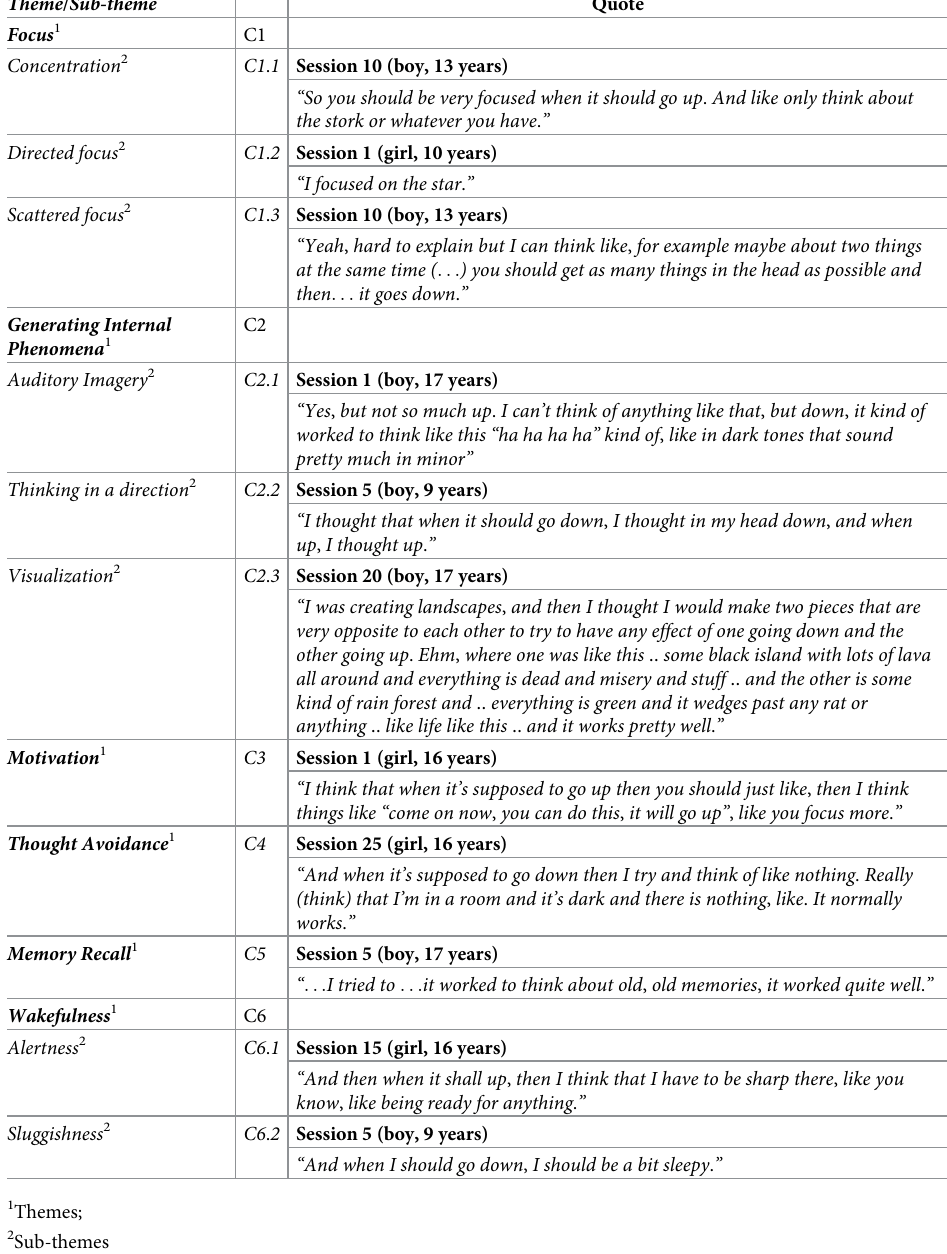
Table 2. Quotes on cognitive strategies during slow cortical potential